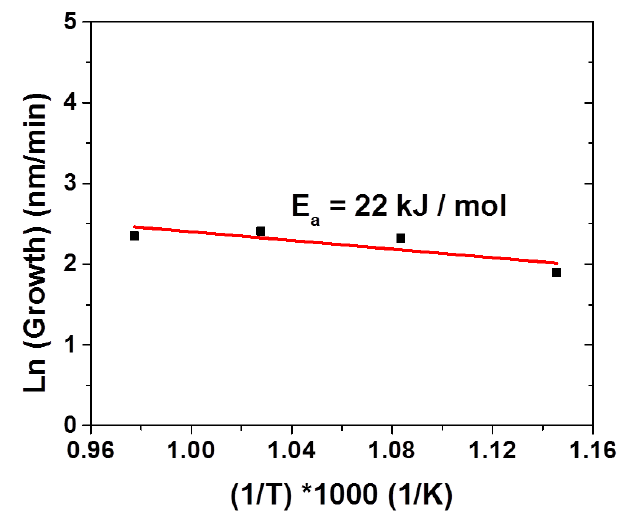
Figure 4. Arrhenius plot of the ln growth rate vs. 1000 / T for the BiFeO 3 MOCVD process starting from the Bi(phenyl) 3 and Fe(tmhd) 3 precursors.